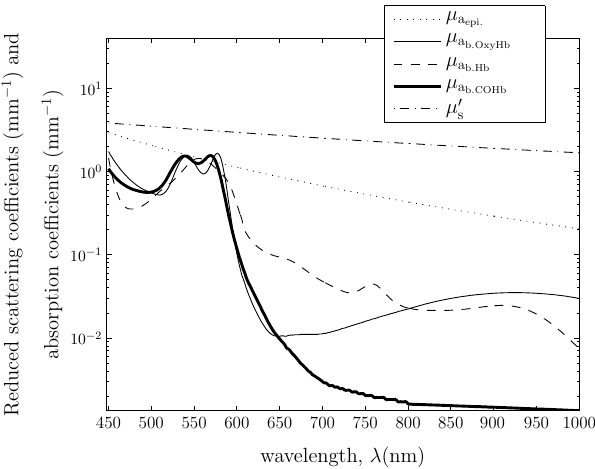
Fig. 1. Reduced scattering coe±cients, (cid:1) 0 s , and epidermal absorption coe±cients ( (cid:1) a ), absorption coe±cients of OxyHb epi : ( (cid:1) a ), Hb ( (cid:1) a ) and COHb ( (cid:1) a ). Total hemoglobin b (cid:3) OxyHb b (cid:3) Hb b (cid:3) COHb concentration is taken to be 268 (cid:1) (cid:3) mol (cid:3) L (cid:2) 1